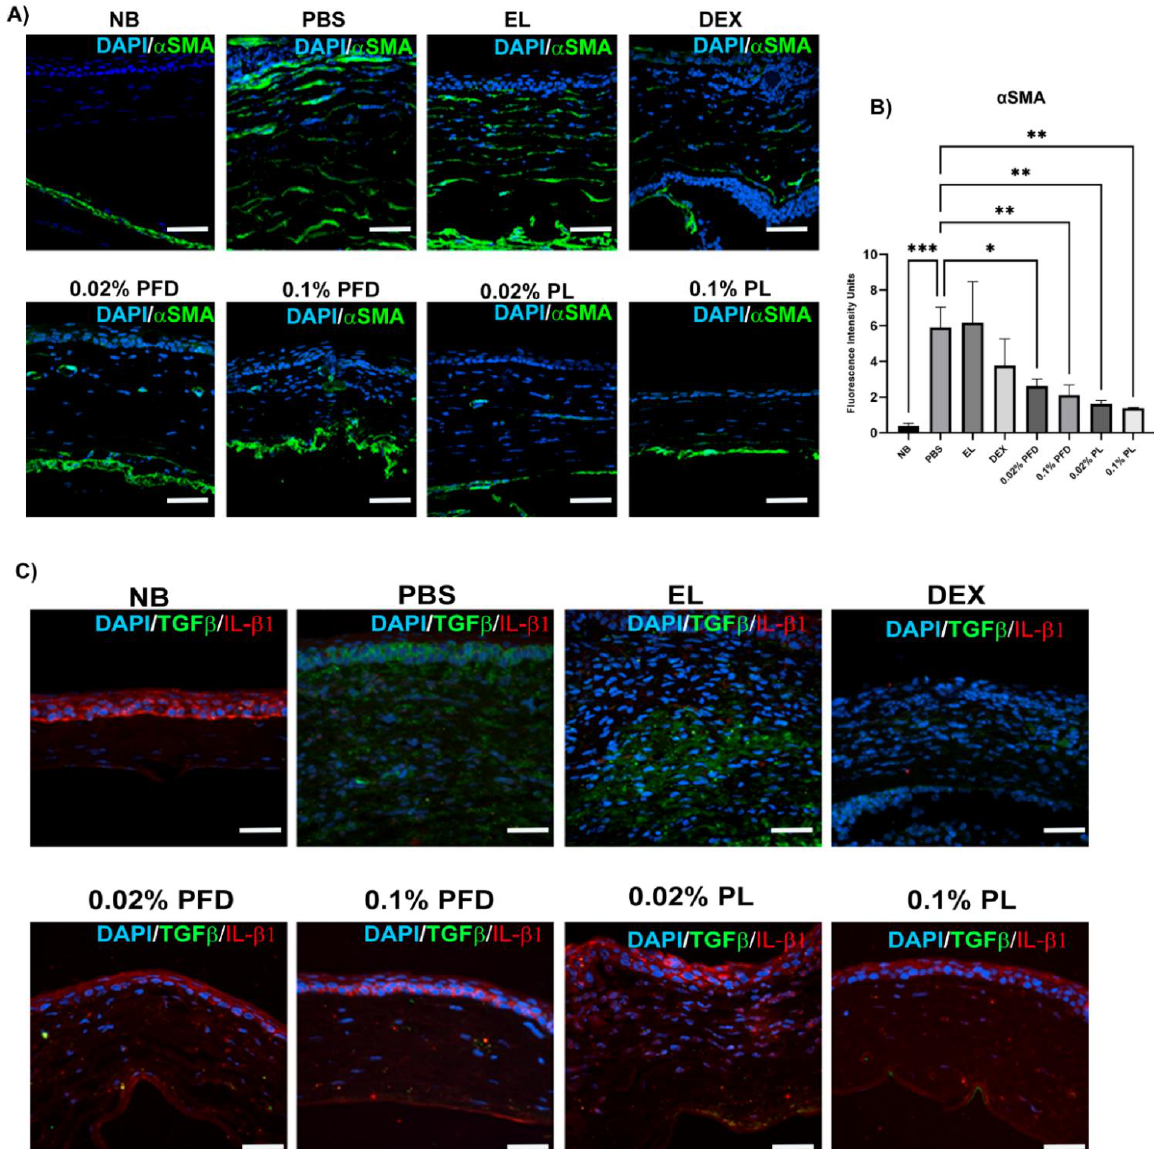
Figure 6. Comparison of α SMA, TGF- β and IL-1 β expression in corneal tissue among different treatments by immunofluorescence. ( A ) PFD suppresses α SMA in a dose-dependent manner, and liposomes improve its effect. Representative immunofluorescence images obtained by confocal mi- croscopy. ( B ) Semi-quantification of α SMA protein expression by fluorescence intensity analysis. Data expressed as mean ± standard deviation. ( C ) PFD suppresses TGF- β in a dose-dependent manner and liposomes improve this effect. Meanwhile, PFD restores normal epithelial location of IL-1 β . Non-burned eyes (NB), PBS treated eyes (PBS), empty liposome treated eyes (EL), dexamethasone treated eyes (DEX), 0.02% PFD treated eyes, 0.1% PFD treated eyes, 0.02% PFD-loaded liposome (PL) treated eyes and 0.1% PL treated eyes. α SMA, α smooth muscle actin; TGF- β , transform- ing growth factor- β ; IL-1 β , interleukin-1 β ; DAPI, 4 (cid:48) ,6-diamidino-2-phenylindole; NB, non-burned; PBS, phosphate-buffered saline; EL, empty liposome; DEX, dexamethasone; PFD, pirfenidone; PL, pirfenidone-loaded liposome. * p < 0.05 vs. PBS group; ** p < 0.01 vs. PBS group; *** p < 0.001 vs. PBS group. Comparison of corneal haze induced by alkali burn after 15 days of